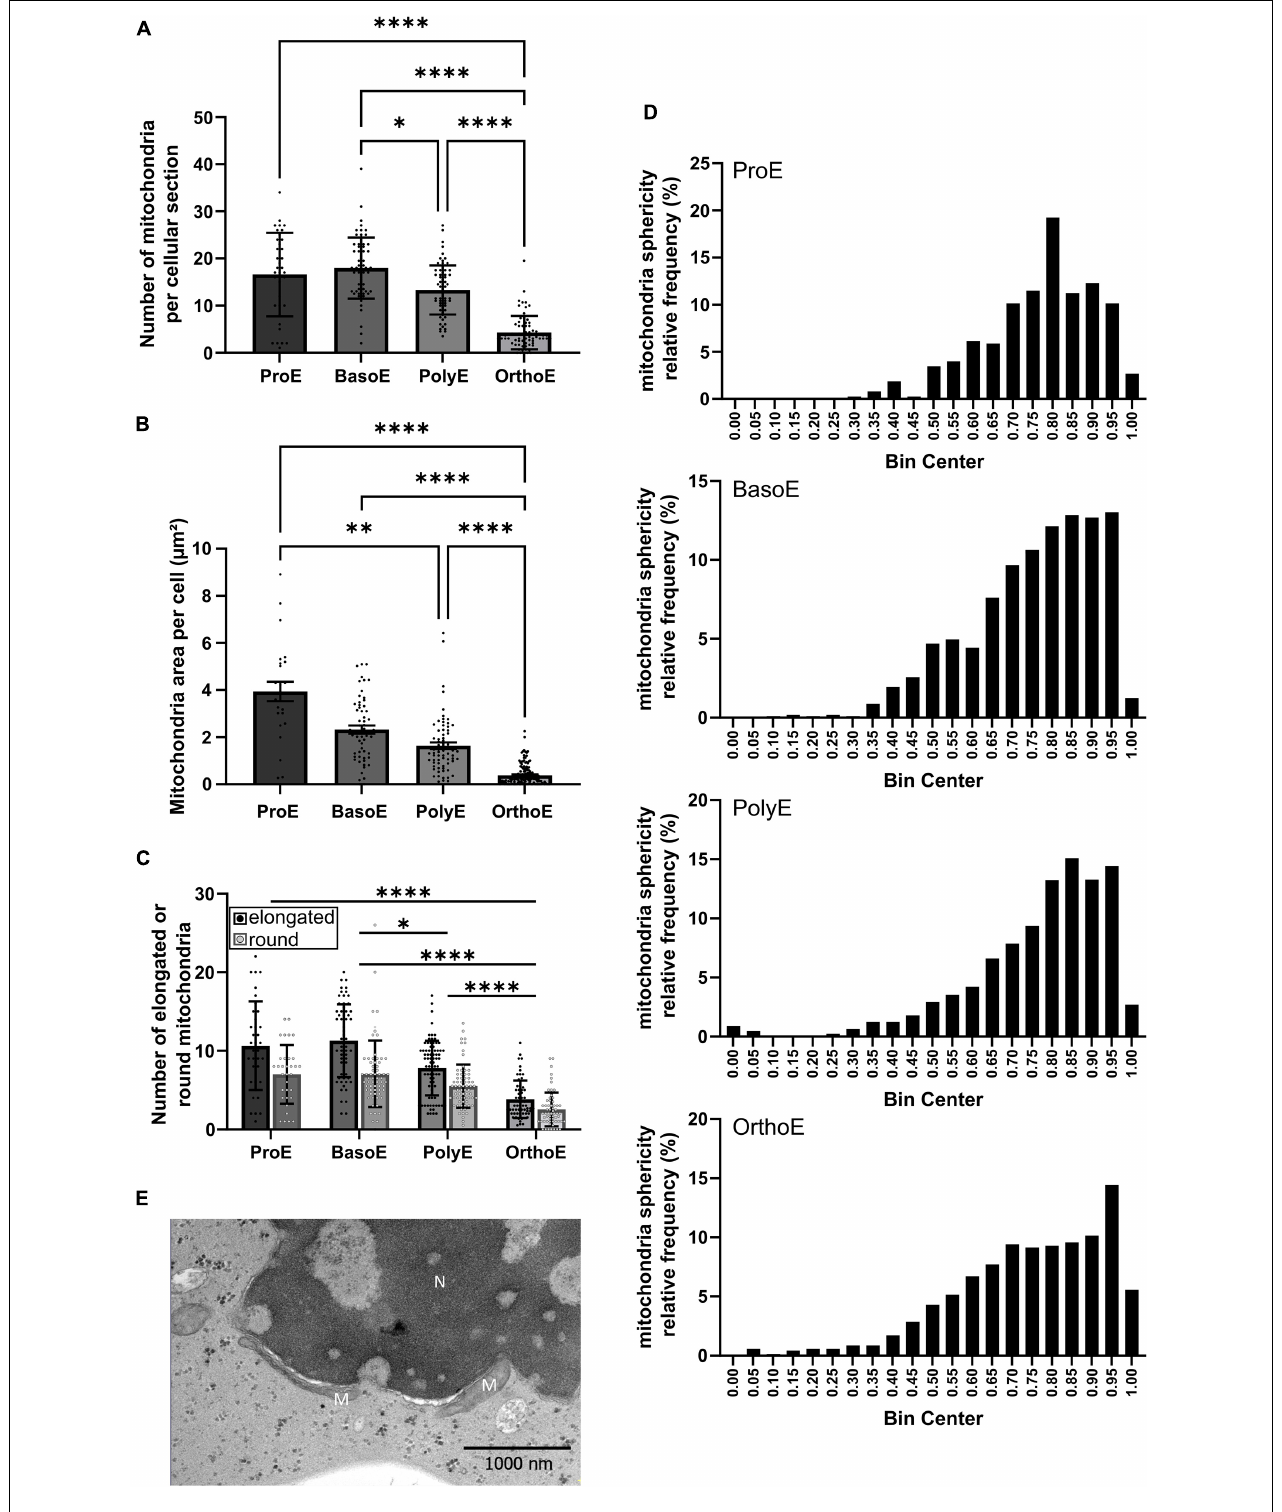
FIGURE 3 | Mitochondria characterization during erythroid differentiation. (A,B) The number (A) and the total area (B) of mitochondria per cell were quantified in the different erythroid differentiation stages. (C,D) Mitochondrial morphology (elongated or rounded shape) was measured manually (C) or using the eccentricity quantification (D) . (E) Elongated mitochondria close to the nucleus of an OrthoE. M, mitochondria; N, nucleus. Kruskal–Wallis analysis on at least 20 images for the three replicates. ∗ p < 0.05; ∗∗ p < 0.01; ∗∗∗∗ p < 0.001.